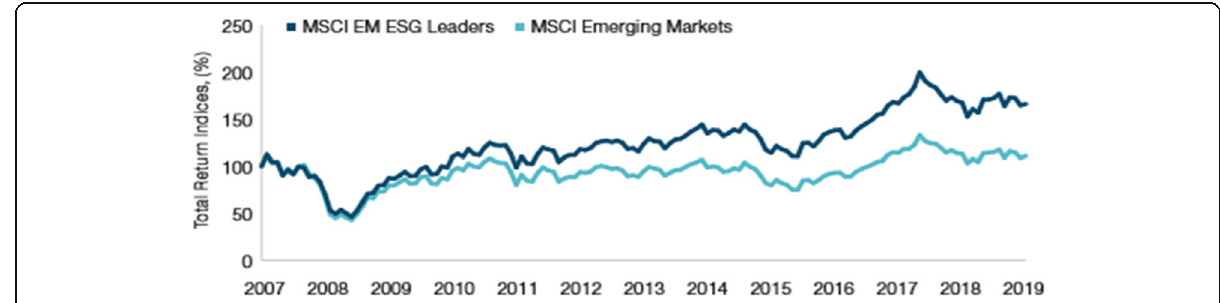
Fig. 3 Cumulative Gross Index Return (September 2007 to September 2019). Source: MSCI, data analysis (Rowe Price,